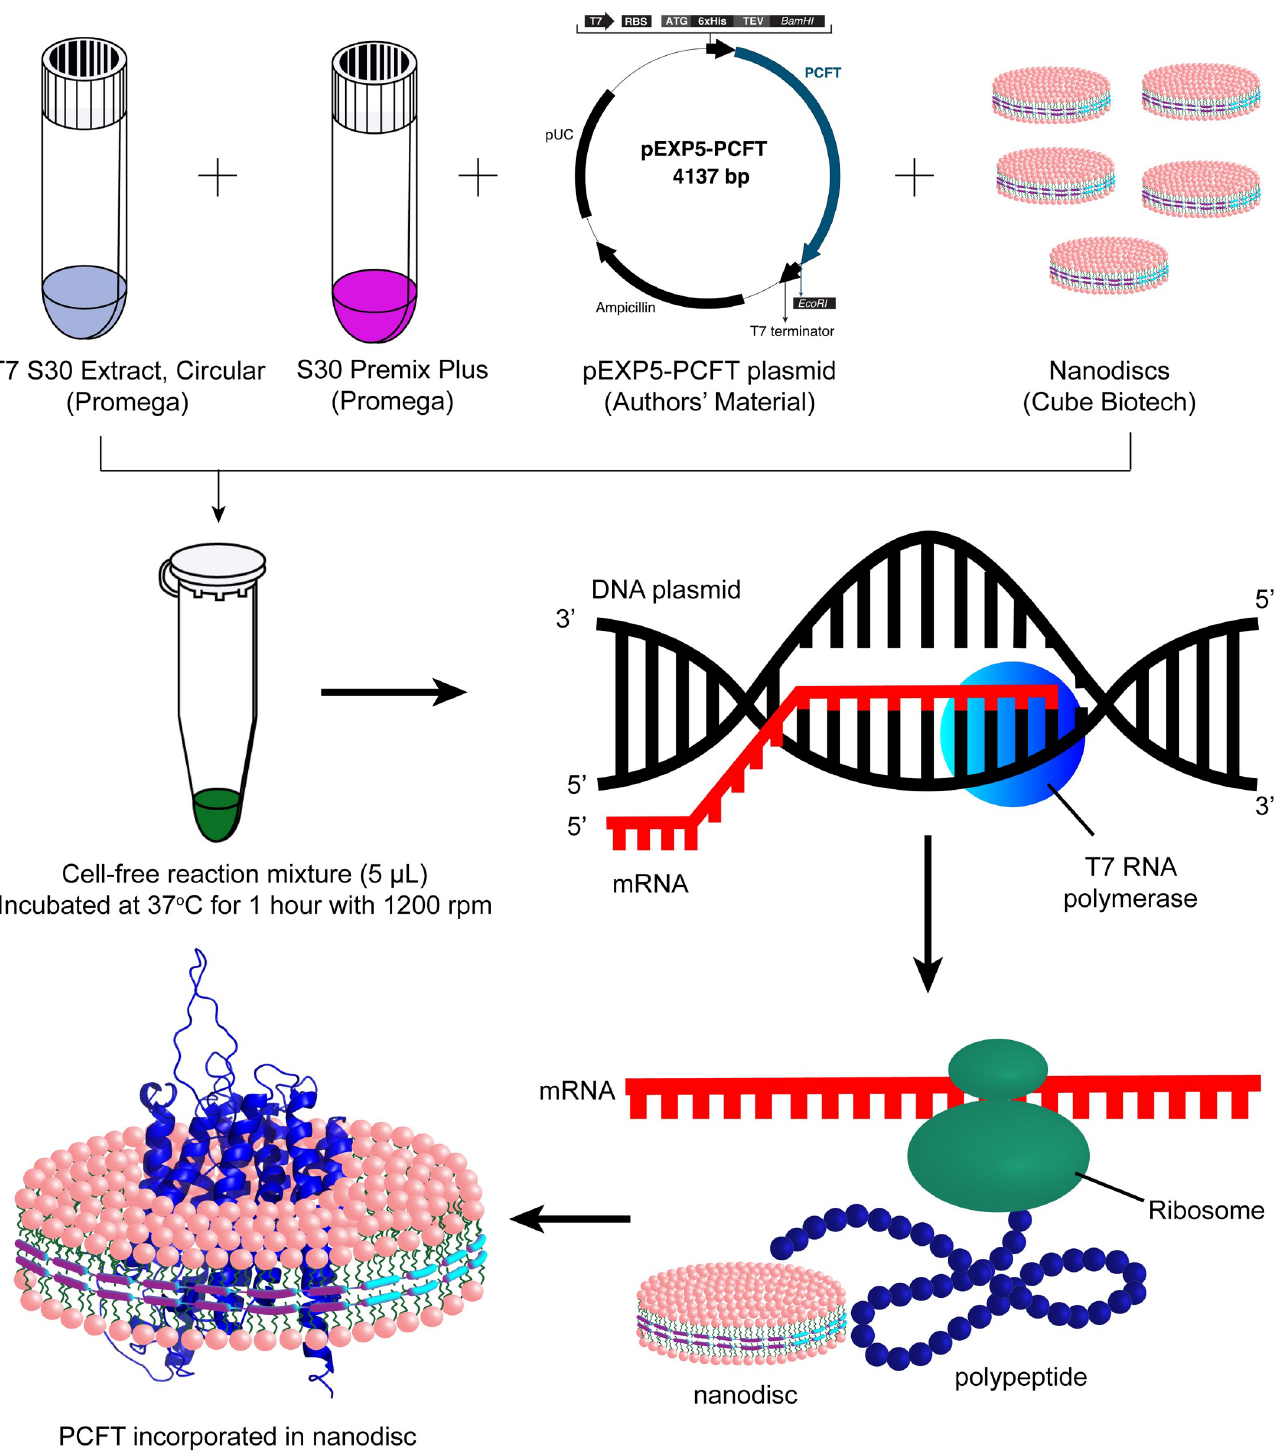
Fig 2. Schematic for cell-free expression of PCFT in the presence of nanodiscs. T7 S30 Extract, Circular, and S30 Premix Plus are components of the S30 T7 High-Yield Protein Expression System purchased from Promega. The pEXP5-PCFT plasmid is the PCFT construct shown in Fig 1. Empty LPNs containing POPC, DMPG, or DMPC were added to a cell-free reaction mixture. Soluble PCFT was observed when PCFT was cell-free expressed in the presence of the nanodisc.